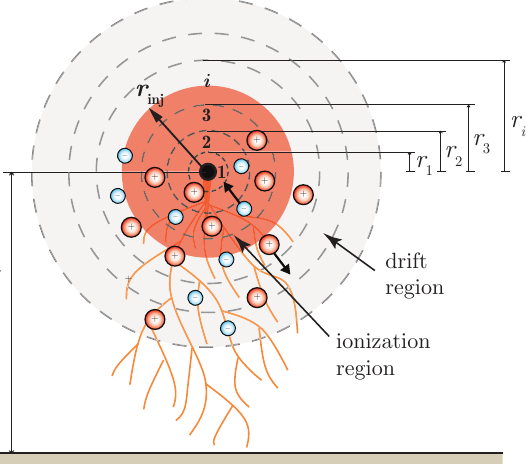
Figure 3. Discretization of the space surrounding the conductor in coaxial cylindrical layers. The ra- dius r inj of the ionization (or injection) area is